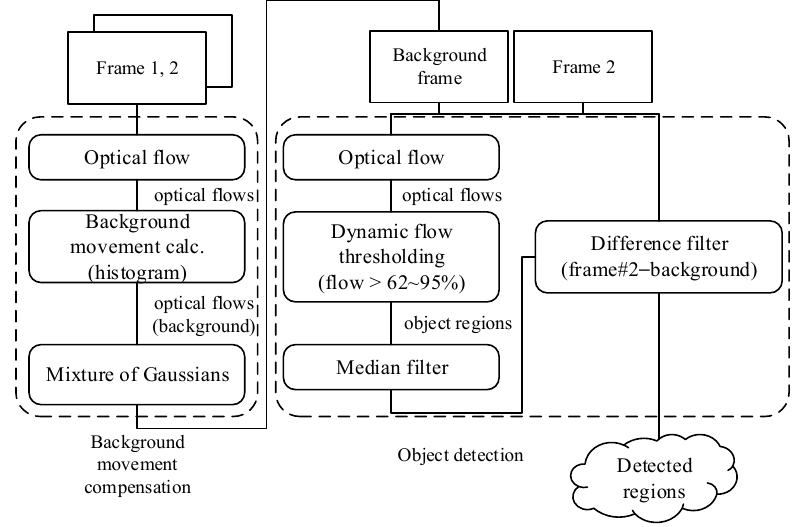
Figure 1. Overall detection procedure of the proposed scheme.